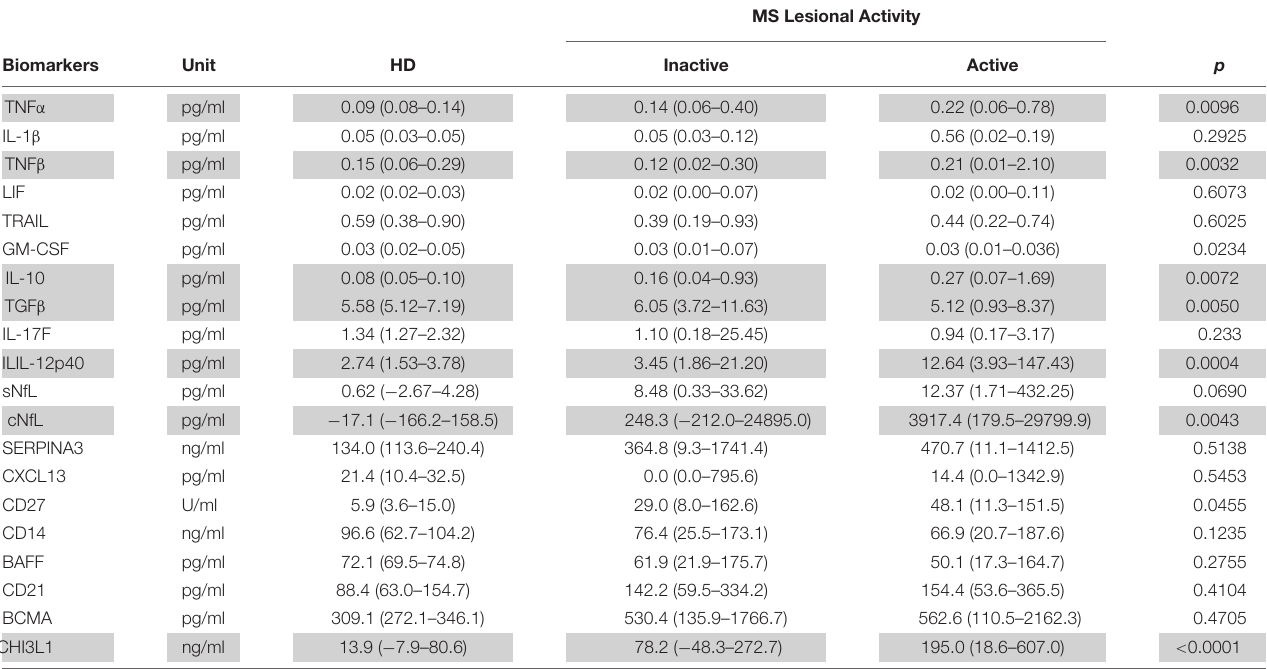
TABLE 4 | In the training cohort, biomarker concentrations across HD ( n = 5) and MS lesional activity subgroups (Inactive and Active, n = 35 each subgroup) are represented as median (range).